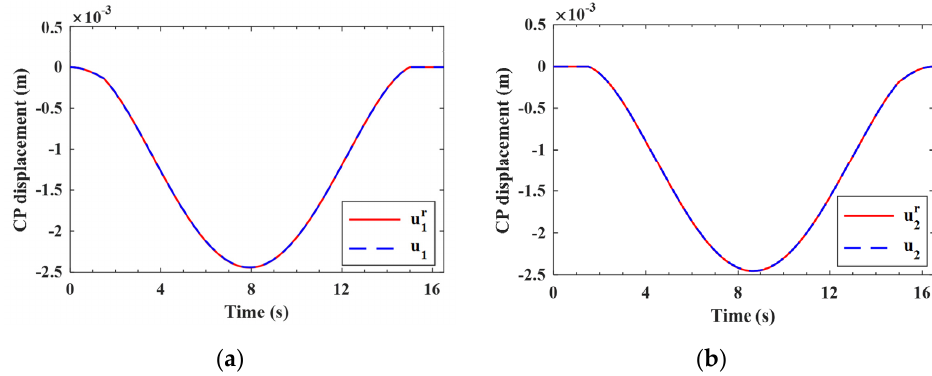
Figure 9. Contact displacements for the two-axle vehicle moving over the bridge. ( a ) front wheel; ( b ) rear wheel.